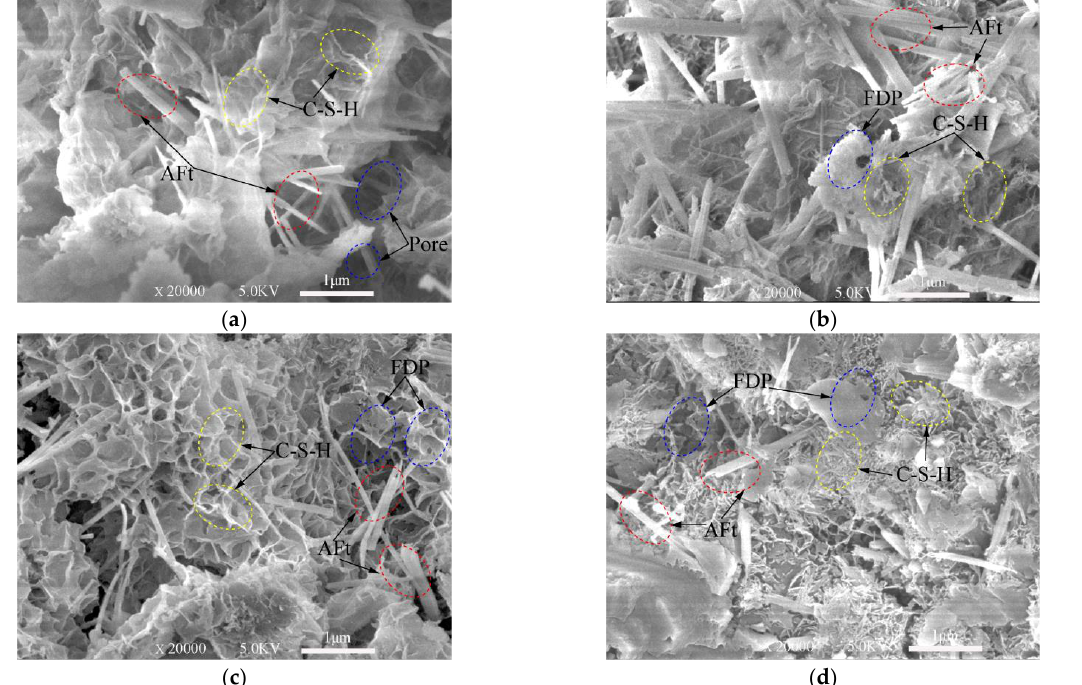
Figure 8. SEM images of 7-day samples under different freeze–thaw cycles. ( a ) Unfrozen; ( b ) After 5 freeze–thaw cycles; ( c ) After 10 freeze–thaw cycles; ( d ) After 20 freeze–thaw cycles.